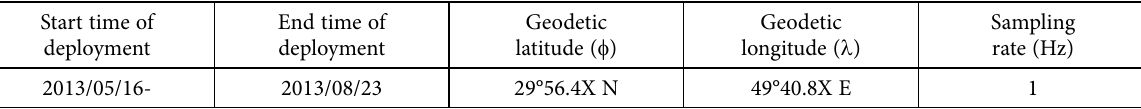
Table 8. Bias and drift of jason-2 estimated by the coastal tide gauge and GPS vessel located at Bushehr port